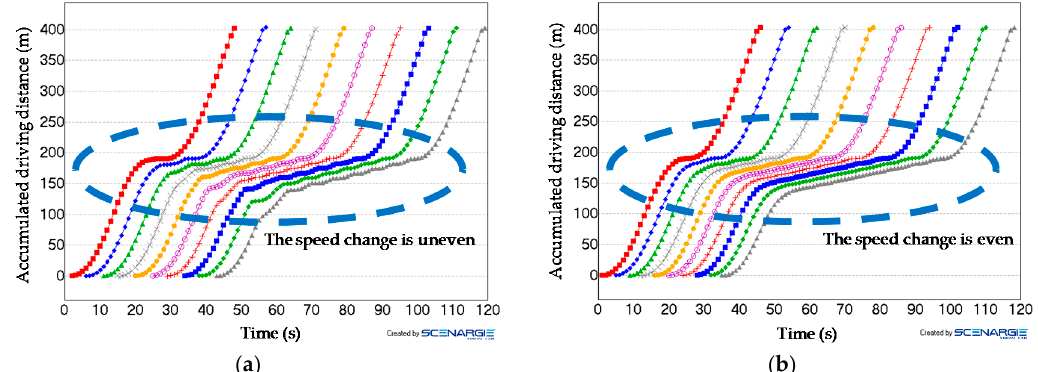
Figure 7. Impact on the vehicle in the back after the low-priority vehicle has stopped at, and then passed through, the intersection. ( a ) Human-driven vehicle; ( b ) self-driven vehicle.